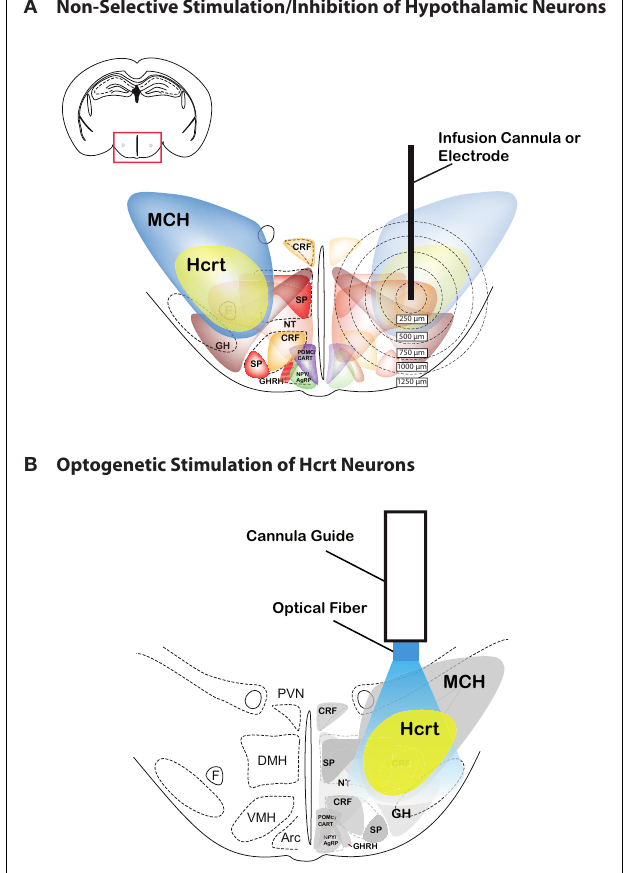
FIGURE 1 | Comparison between electrical/pharmacological activation or inhibition and optogenetic activation of Hcrt neurons in the lateral hypothalamus. 2D architecture of the Hcrt fi eld showing the heterogeniety of cell types found in the lateral hypothalamus, including MCH, Hcrt, corticotropin-releasing factor (CRF), NPY/AgRP, POMC/CART, growth hormone-releasing hormone (GHRH), growth hormone (GH), neurotensin (NT), and substance P. Note that, in addition to these defi ned cell types, the hypothalamus contain glutamatergic and GABAergic neurons. For clarity, Nesfatin-1, thyrotropin-releasing hormone (TRH), vasopressin and oxytocin are not represented. (A) Limitations of traditional microstimulation or pharmacological techniques to perform loss-of-function or gain-of function studies include confounding effect on neuronal and non-neuronal cells surrounding the tarted cells. For instance, infusion of Hcrt peptide or non-peptide agonists or antagonists can spread up to 1000 µm away from the infusion site, therefore activating or inhibiting several neuronal populations in addition to the Hcrt neurons. Alternatively, temporally precise microelectrode stimulation cannot distinguish between cell types in the stimulated area, and thus may inadvertently stimulate other, unintended regions that are adjacent to the electrode. Concentric circles represent distance (in µm) from possible injection, stimulation or lesion site. (B) Optogenetic technology allow selective stimulation (using ChR2) or inhbition (using NpHR) of genetically targeted Hcrt neurons, with no confounding modulation of surrounding cells that may regulate the same brain